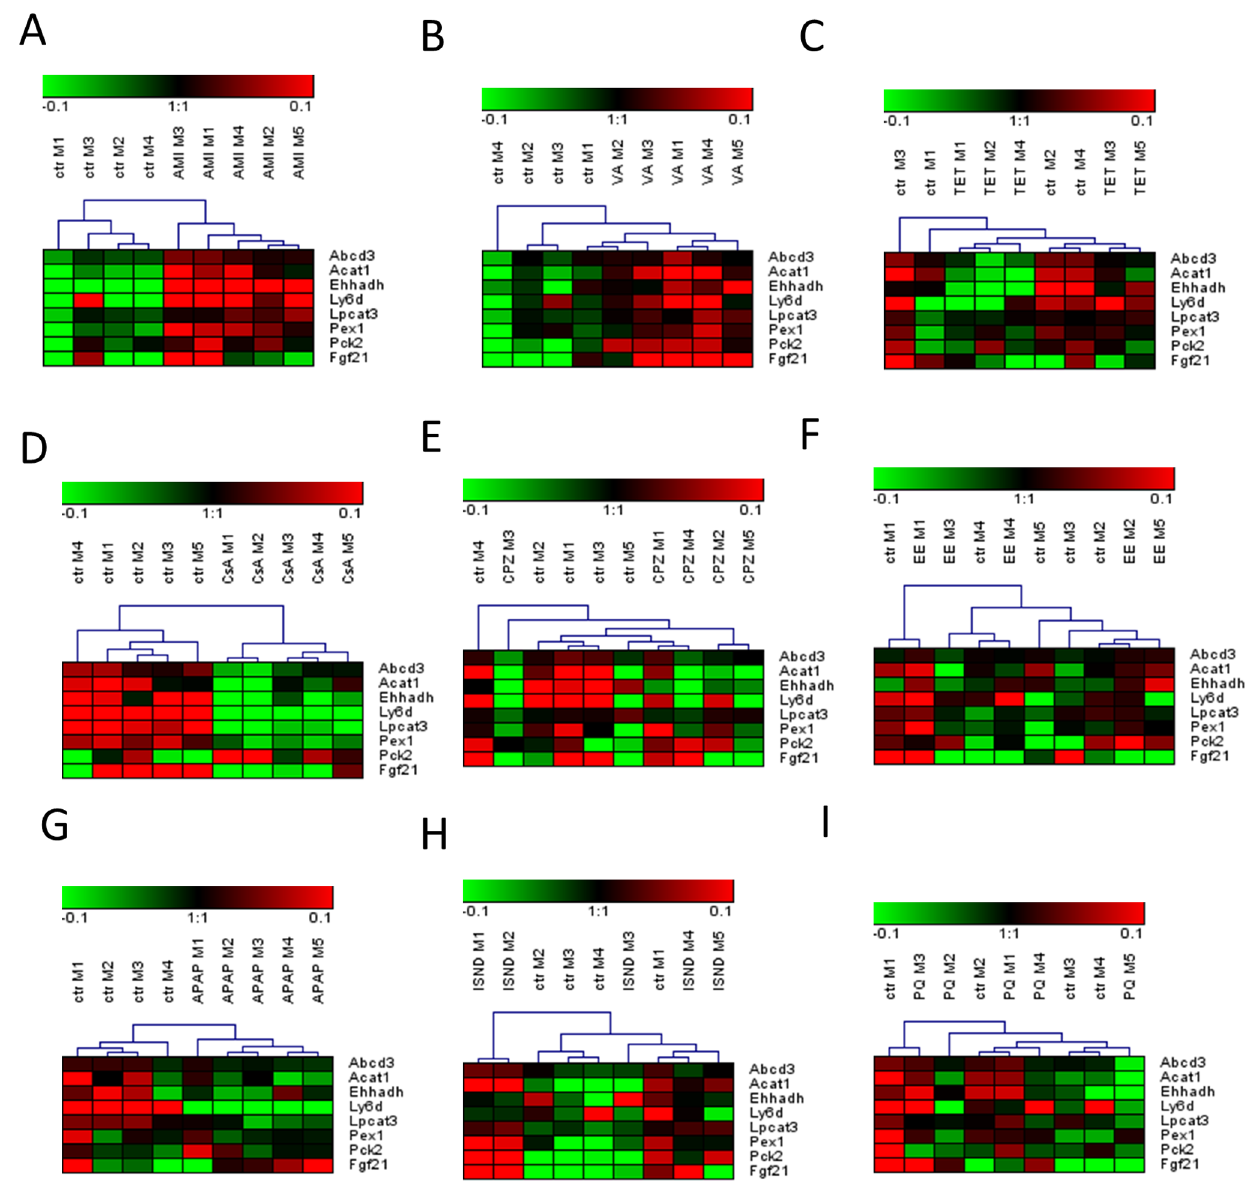
Figure 7. Identification of potential biomarkers for PPAR agonists in mouse PCLS. PCLS obtained from 4 or 5 mice were exposed for 24 h to model toxicants for steatosis (amiodarone (A), valproic acid (B), or tetracycline(C)), cholestasis (cyclosporin A (D), chlorpromazine (E), or ethinyl estradiol (F)), necrosis (acetaminophen (G), isoniazid (H), or paraquat (I)), or controls. GSEA led to the identification of 8 genes upregulated by amiodarone and valproic acid, which were considered as candidate biomarkers for PPAR agonists. mRNA expression values for the selected biomarkers are derived from DNA-microarrays and results are presented as heat maps of log2, median centered gene expression values subjected to HCA. Red and green indicate expression higher and lower, respectively, than the average expression of all samples within the same heat map. AMI stands for amiodarone, VA-valproic acid, TET- tetracycline, CsA-cyclosporin A, CPZ- chlorpromazine, EE- ethinyl estradiol, APAP-acetaminophen, ISND- isoniazid, PQ- paraquat, and ctr- controls, M1 represents PCLS obtained from liver of mouse nr 1 etc.